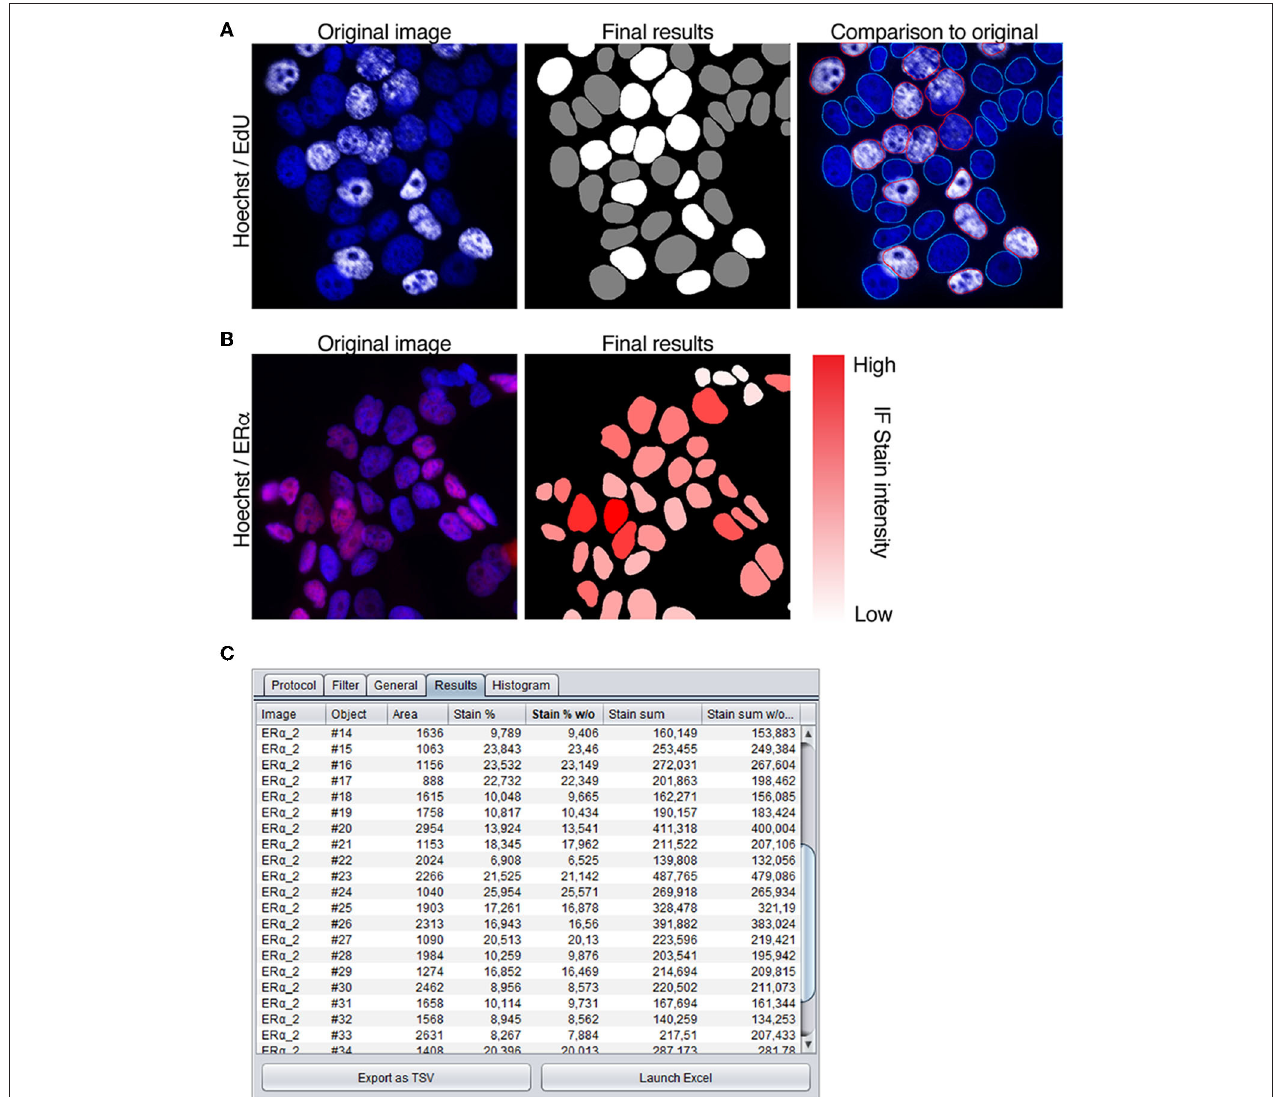
FIGURE 4 | Intensity measurement protocols. (A) MCF7 cells stained with nuclear stain (Hoechst) and to detect EdU (white) incorporated cells. To quantitate EdU positive cells, nuclei are segmented using the Hoechst channel and a threshold is set to determine positive staining. In final results image nuclei that are negative for EdU staining are marked gray, and positive nuclei white. Comparison to original image shows overlay of segmentation mask marked with positive (red) and negative (blue) nuclei (B) MCF7 cells immunostained with ER α antibody (red), segmented using nuclear stain channel (Hoechst) and measured for intensity of the staining. Immunofluorescence intensity is indicated with the color slider (white–low intensity, red–high intensity). (C) Numeric output of the intensity measurement protocol shown in the results